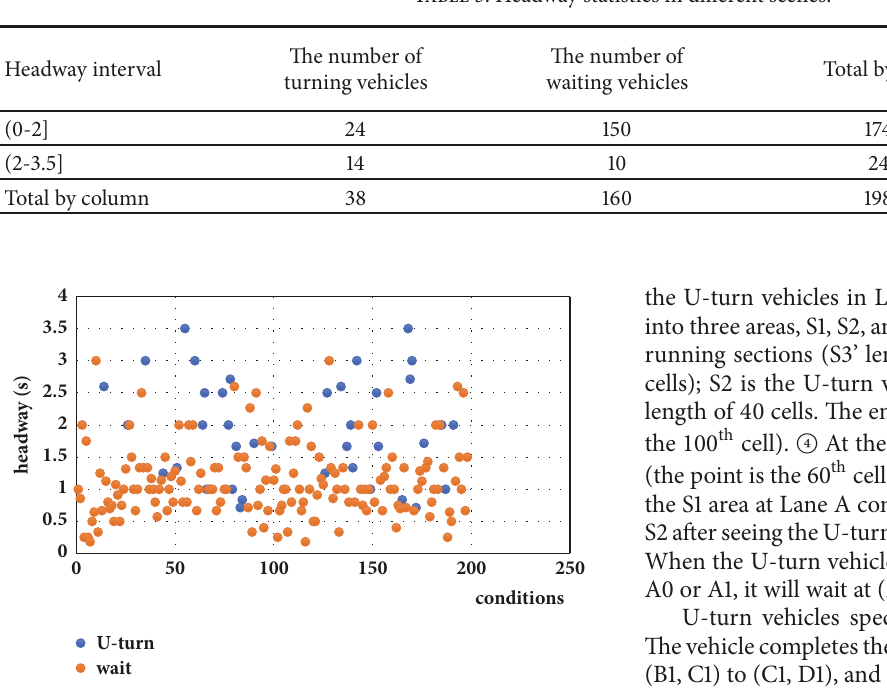
Figure 4: Observed game results in different